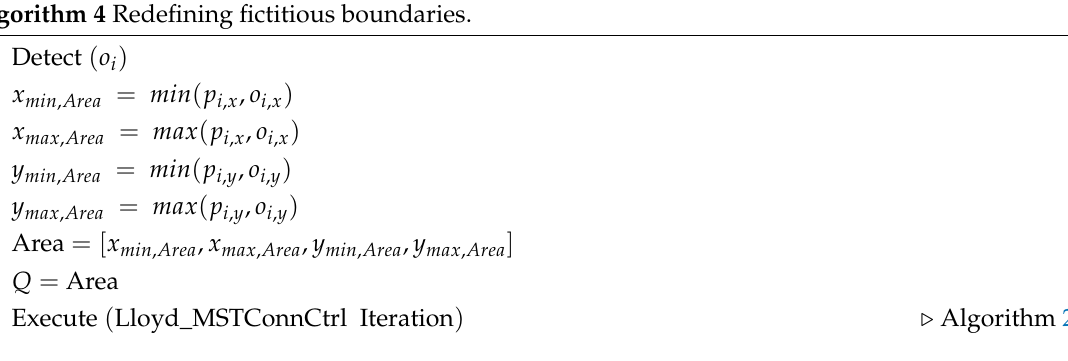
Algorithm 4 Redefining fictitious